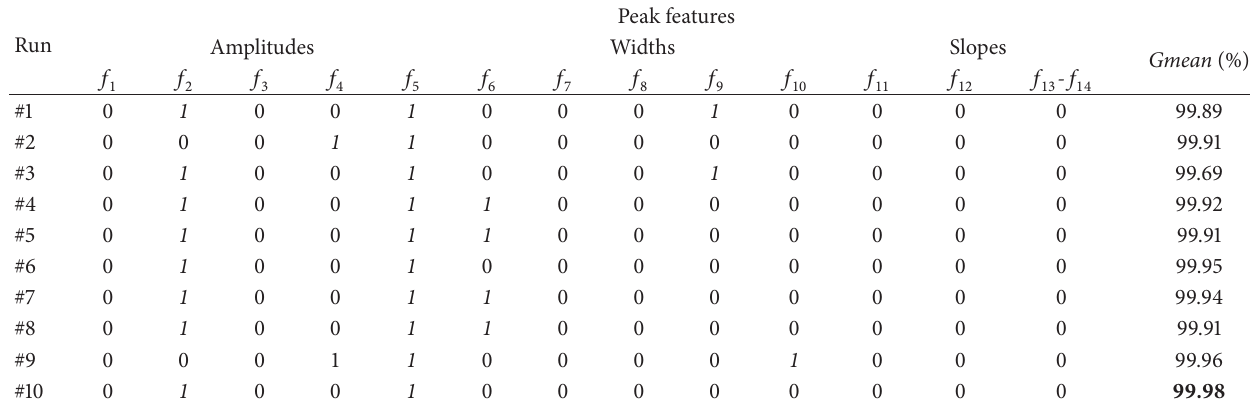
Table 9: Training results: the feature sets of 10 runs using standard PSO.